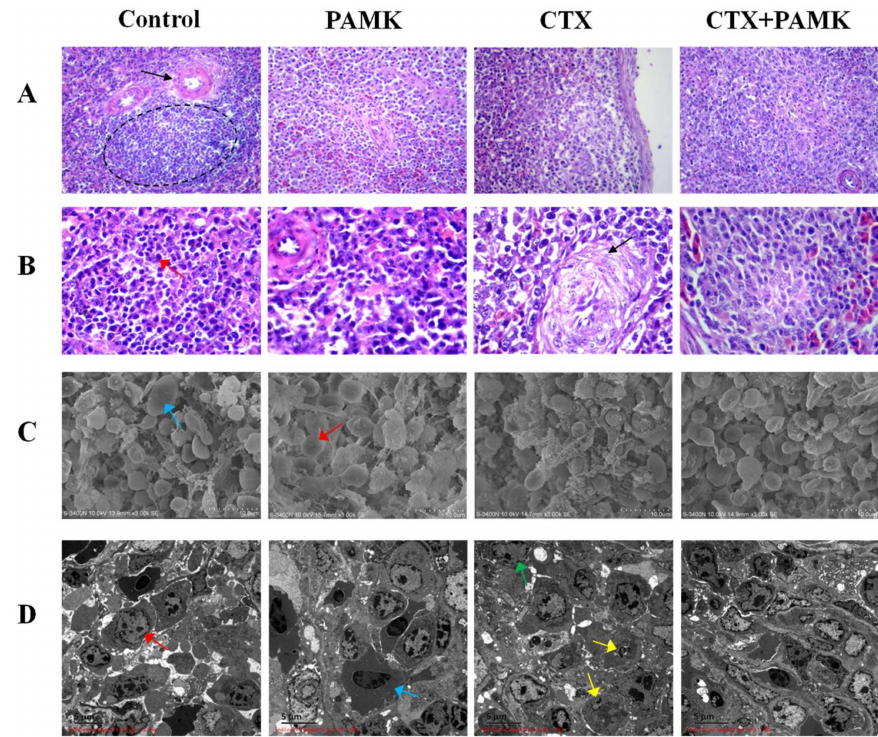
Figure 2. Effects of PAMK on histology and ultramicroscopic morphology of the spleen of geese treated with CTX. ( A ) Hematoxylin and eosin (HE) staining of the spleen (400 × ); ( B ) HE staining of the spleen (1000 × ); ( C ) Scanning electron microscopy (SEM; 3000 × ) of the spleen. ( D ) Transmission electron microscopy (TEM; 3000 × ) of the spleen. Circles indicate the periarterial lymphatic sheath (PLS), the black arrow points to the artery, the red arrow indicates a lymphocyte, the yellow arrow points to an apoptotic lymphocyte, the green arrow reveals in a lymphocyte that chromatin is concentrated on the nuclear membrane, and the blue arrow indicates an